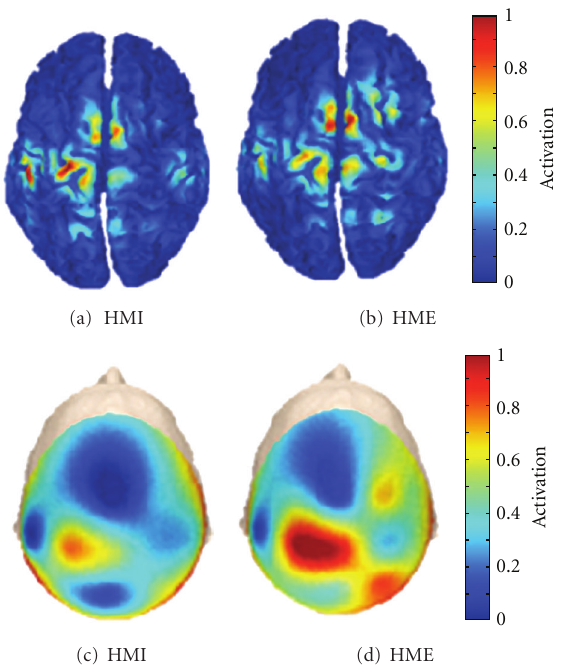
Figure 3: First row: cortical source activation maps for (a) Hand Motor Imagery (HMI) and (b) Hand Motor Execution (HME). Second row: scalp area activation maps for (c) HMI and (d) HME. All images are from a single subject, and a lower level of activation can be observed in imagery as compared to the corresponding instance during execution.